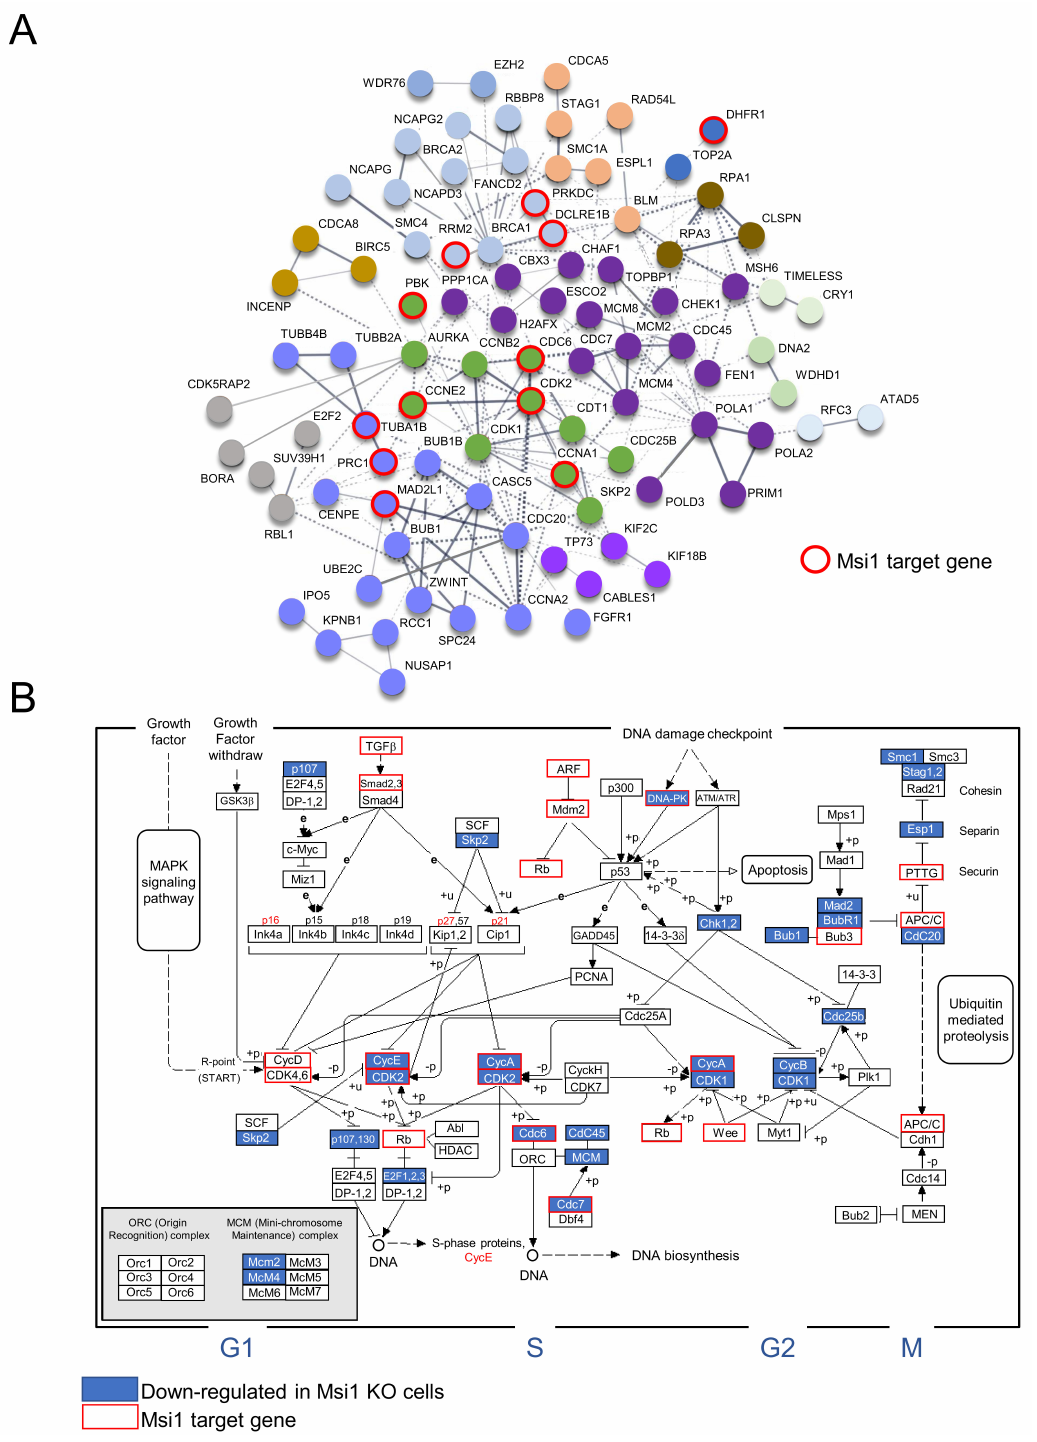
Figure 2. Msi1 impact on cell cycle and division. ( A ) Network shows cell cycle and/or division genes downregulated in Msi1 KO GBM cells in comparison to controls. The network was built using String [28] considering interaction (experimental evidence), text mining and co-occurrence. Different colors were used to indicate clusters of strongly related genes; Msi1 targets previously identified by CLIP or RIP [3,9,23] are labeled in red. ( B ) The impact of Msi1 KO on cell cycle is shown using KEGG’s cell cycle pathway. Downregulated genes in U251 and U343 Msi1 KO cells in comparison to respective controls are in blue boxes and Msi1 targets previously identified by CLIP or RIP [3,9,23] are labeled in